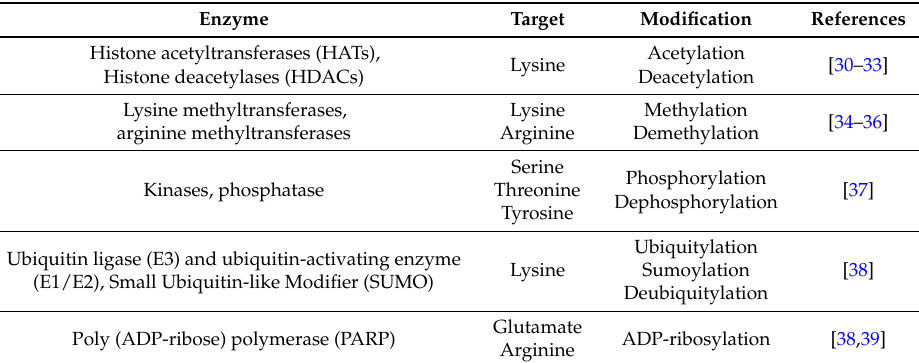
Table 1. The main reversible histone